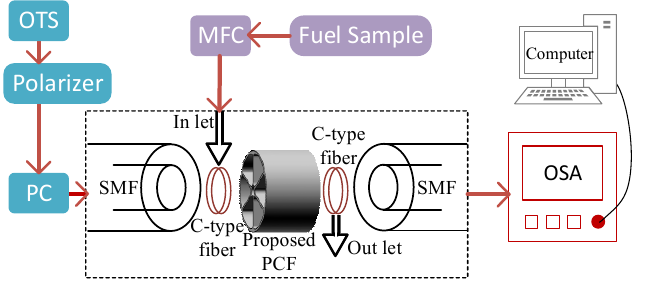
Figure 2. An operational approach for the pragmatic execution of the proposed sensor.